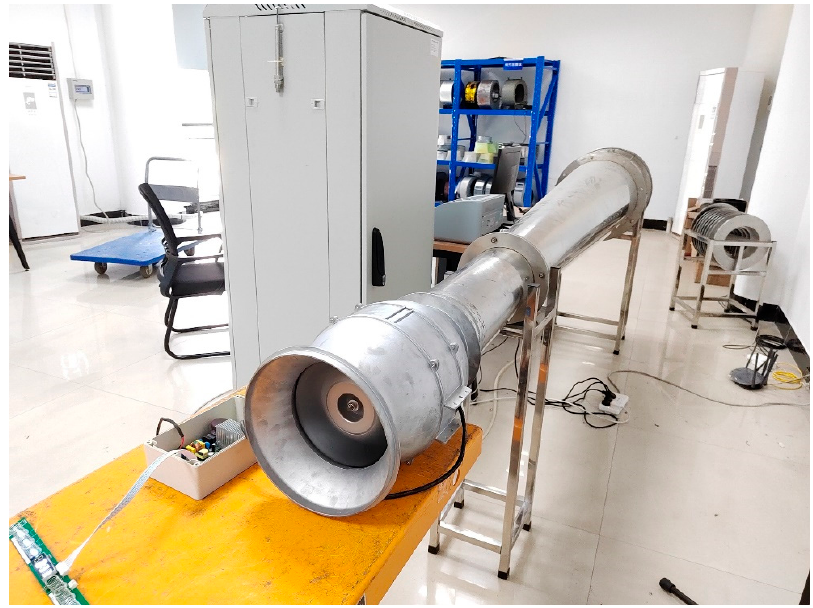
Figure 15. The aerodynamic performance test device.